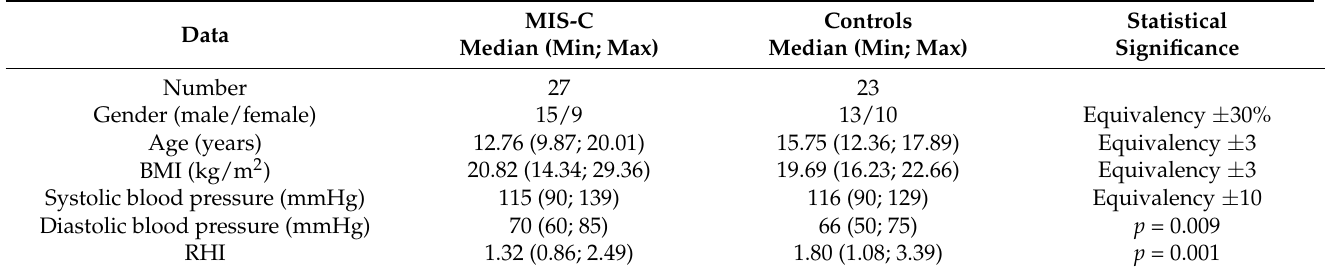
Table 1. Demographic data and RHI, and statistical analysis of MIS-C vs. HI.